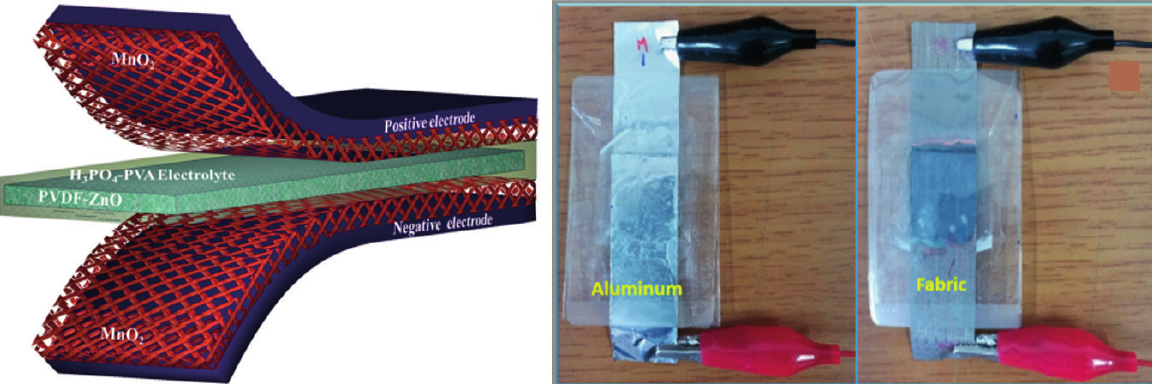
nanowires as positive and negative electrodes 2